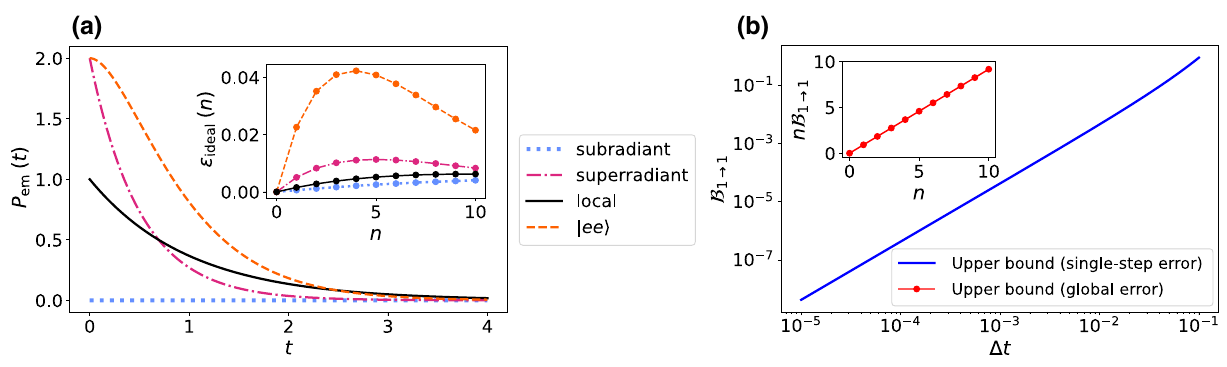
FIG. 1. (a) The emission power as a function of time, when the initial state is the subradiant state (dotted light blue line), the superradiant state (dash-dotted magenta line), and | ee (cid:5) (dashed orange line), and when the dynamics are local, starting from the subradiant state (continuous black line). The inset in (a) shows the trace distance between the real and the simulated state (cid:9) ideal ( n ) as a function of the number of time steps n , with the same initial states as in the main figure. (b) The upper bound B 1 → 1 for the single-step error (cid:9) s as a function of the time step (cid:11) t . The inset in (b) shows the upper bound for the global error (cid:9) g with (cid:11) t = 0.1, equal to n times